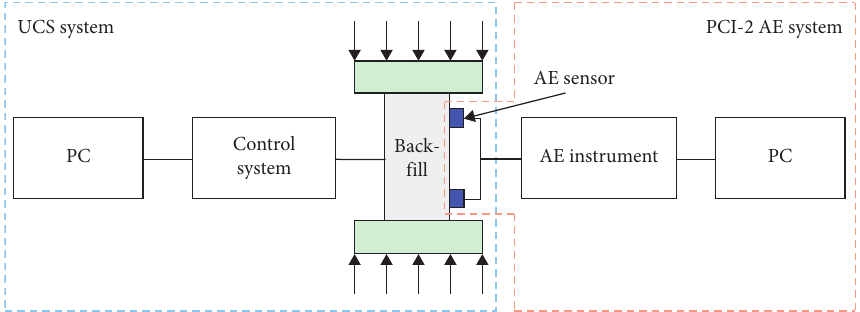
Figure 2: The logic diagram of the SLB100 loading machine and PCI-2 acoustic wave system.